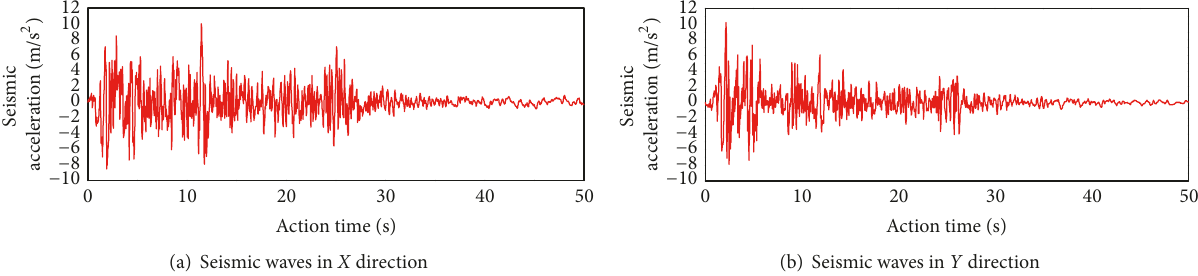
Figure 2: Seismic waves in time-domain in X and Y directions.